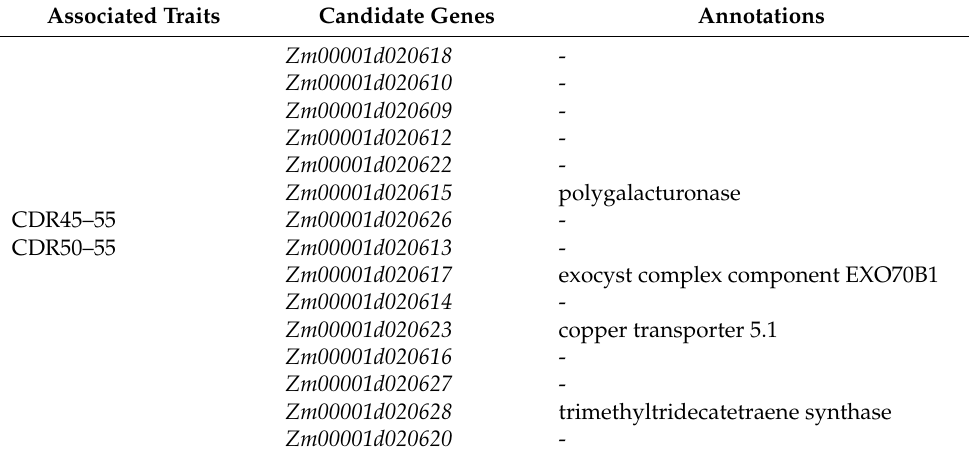
Figure 2. Significant SNPs detected by GWAS using FarmCPU model. ( A ) Manhattan diagram of GWAS results for moisture changes. The blue, red, and turquoise dots represent the significant SNPs associated with CDR50–55, CDR45–55, and KMC45, respectively. CDR50–55 and CDR45–55 represent cob dehydration rate at 50–55 and 45–55 days after pollination, respectively; KMC45 represents kernel moisture content on the 45th day after pollination. The red broken line represents the significant threshold of 1.82 × 10 − 6 . ( B ) Quantile–quantile (Q–Q) plot of GWAS results for moisture changes. The blue, green, and yellow dots represent the SNPs associated with CDR50–55, CDR45–55, and KMC45, respectively. CDR50–55 and CDR45–55 represent cob dehydration rate at 50–55 and 45–55 days after pollination, respectively. KMC45 represents kernel moisture content on the 45th day after pollination. Table 2. Annotations of candidate genes scanned from co-localized significant SNP (SYN38588) detected by GWAS.